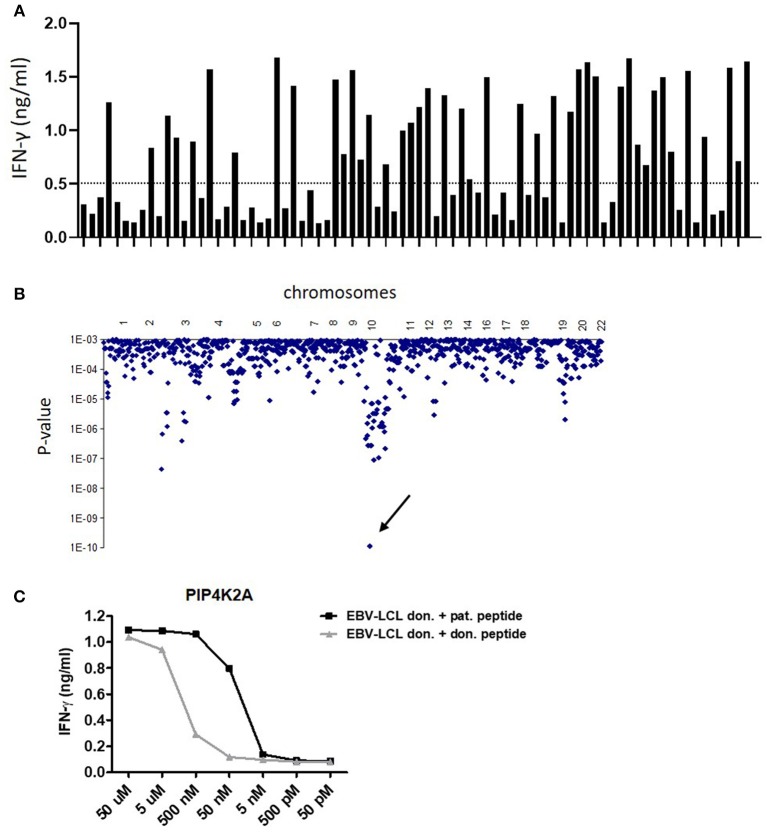
Identification of LB-PIP4K2A-1S as new HLA class II-restricted minor histocompatibility antigen by whole genome association scanning. (A) T-cell recognition of a panel of 80 HLA-DRB1*0301 transduced EBV-LCL. Bars represent the level of IFN-γ (ng/ml) in ELISA released by clone 100 upon co-incubation with the different EBV-LCL. (B) Whole genome association scanning of the recognition data for 80 HLA-DRB1*0301 transduced EBV-LCL and the corresponding SNP data revealed one strongly correlating missense SNP in PIP4K2A (rs10828317) (arrow). The y-axis indicates P-values for the significance of association between SNPs and T-cell recognition of EBV-LCL. The x-axis represents the 1 million tested SNPs as distributed over the human chromosomes. (C) Synthetic peptides of patient and donor variants were loaded on donor EBV-LCL in indicated concentrations and recognition by T-cell clone 100 was measured in IFN-γ ELISA. The LB-PIP4K2A-1S-specific T-cell clone 100 also showed recognition of the donor PIP4K2A-1N variant at peptide concentrations over 50 nM.